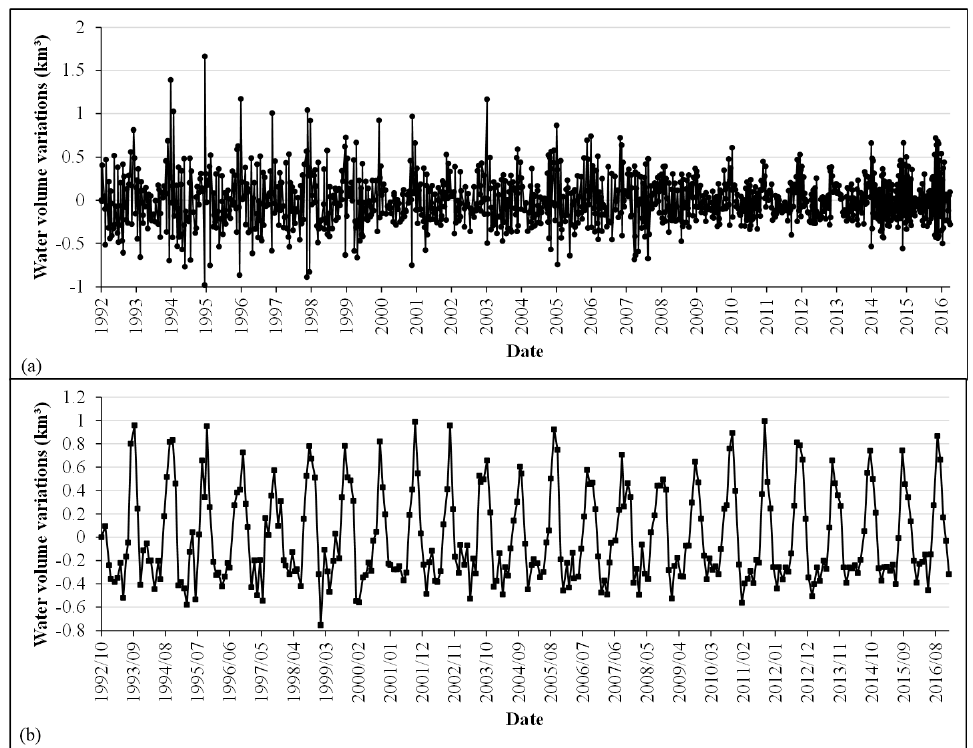
Figure 16. Variation of ∆V of the SPLC on: daily ( a ); and monthly ( b ) scale.